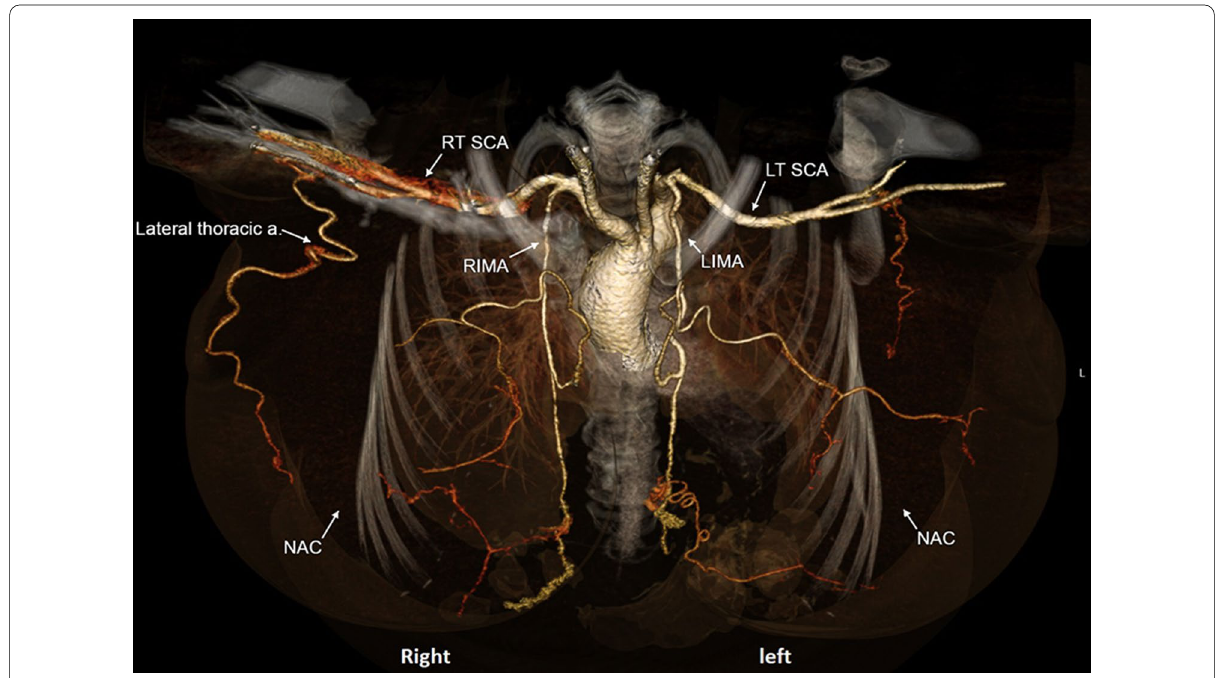
Fig. 2 Different dominant arterial supply to NAC in the same patient. Semitransparent 3D volume-rendered image showing Dominant lateral thoracic artery on the right side reaching NAC with dominant LIMA perforators on the left side reaching NAC